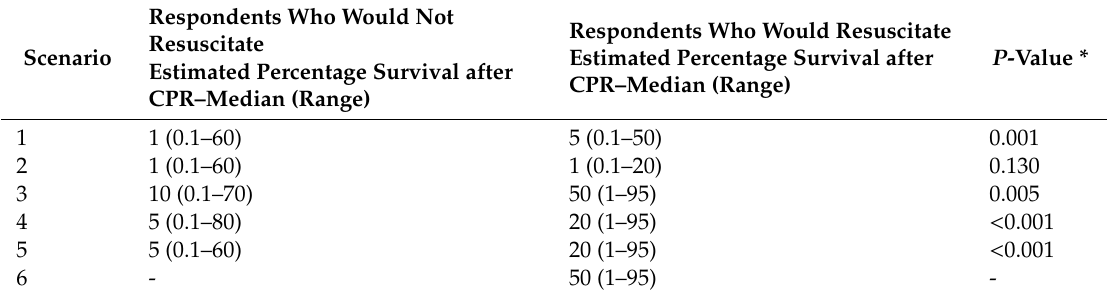
Table 3. Resuscitation decision with median estimated survival range by scenario.